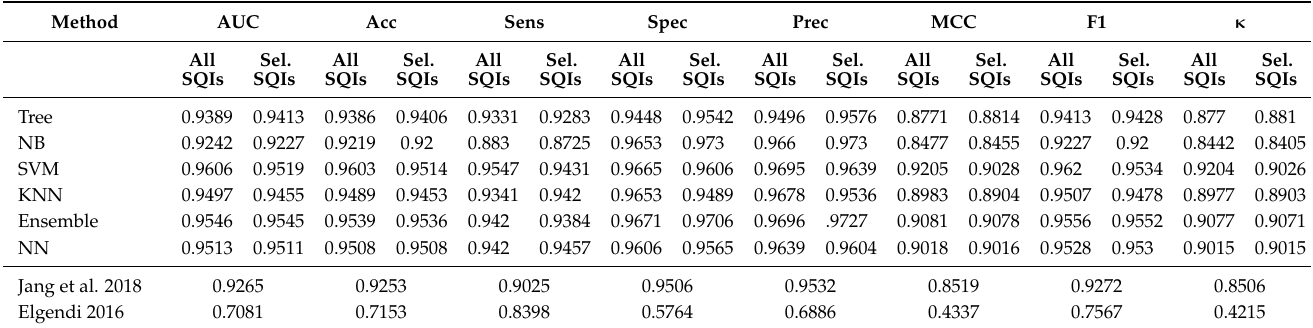
Table 4. Performances for Basic-quality classifiers.